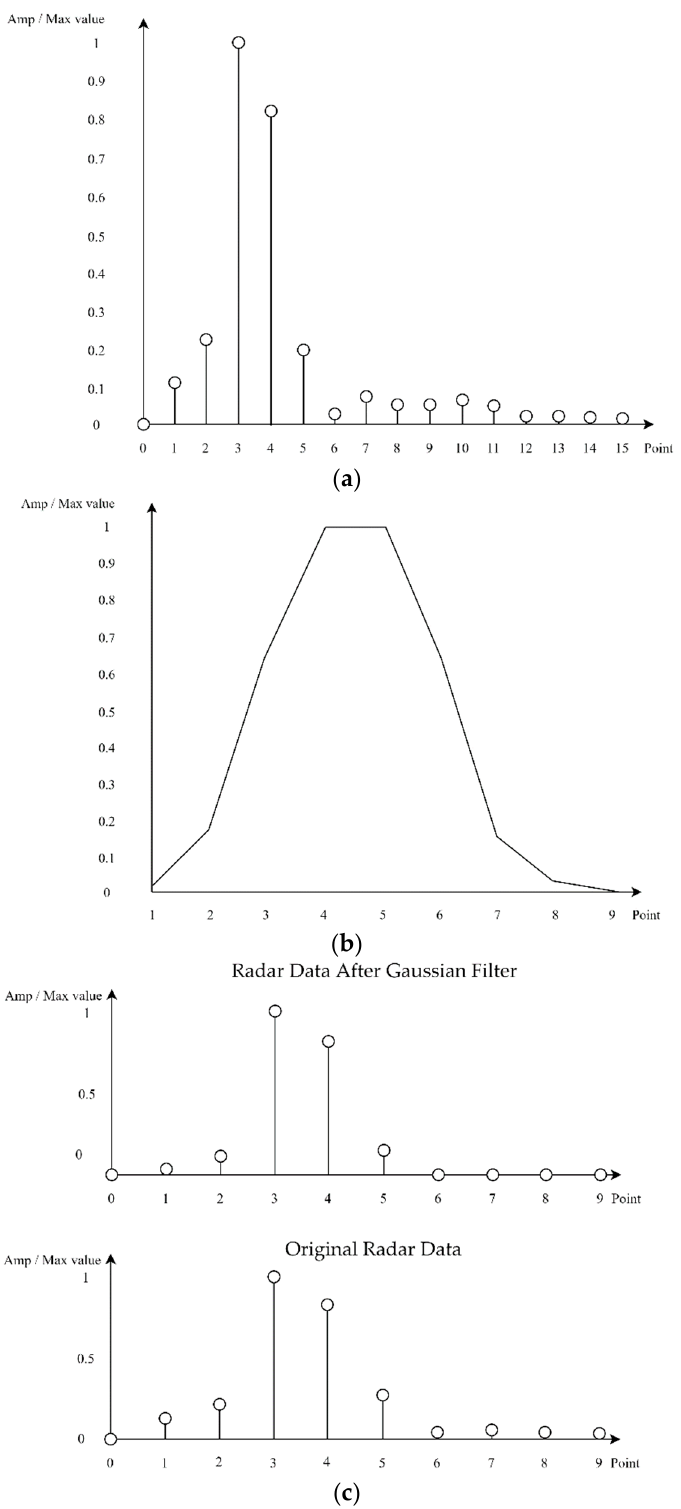
Figure 9. Frequency Domain Signal for the result of isolating Gaussian filters and multiple targets. ( a ) Frequency-domain RADAR signals for two targets; ( b ) Frequency response characteristics of Gaussian filter; ( c ) Comparison between a single target extracted through a Gaussian filter from multiple targets and a single target measured through a RADAR simulation.